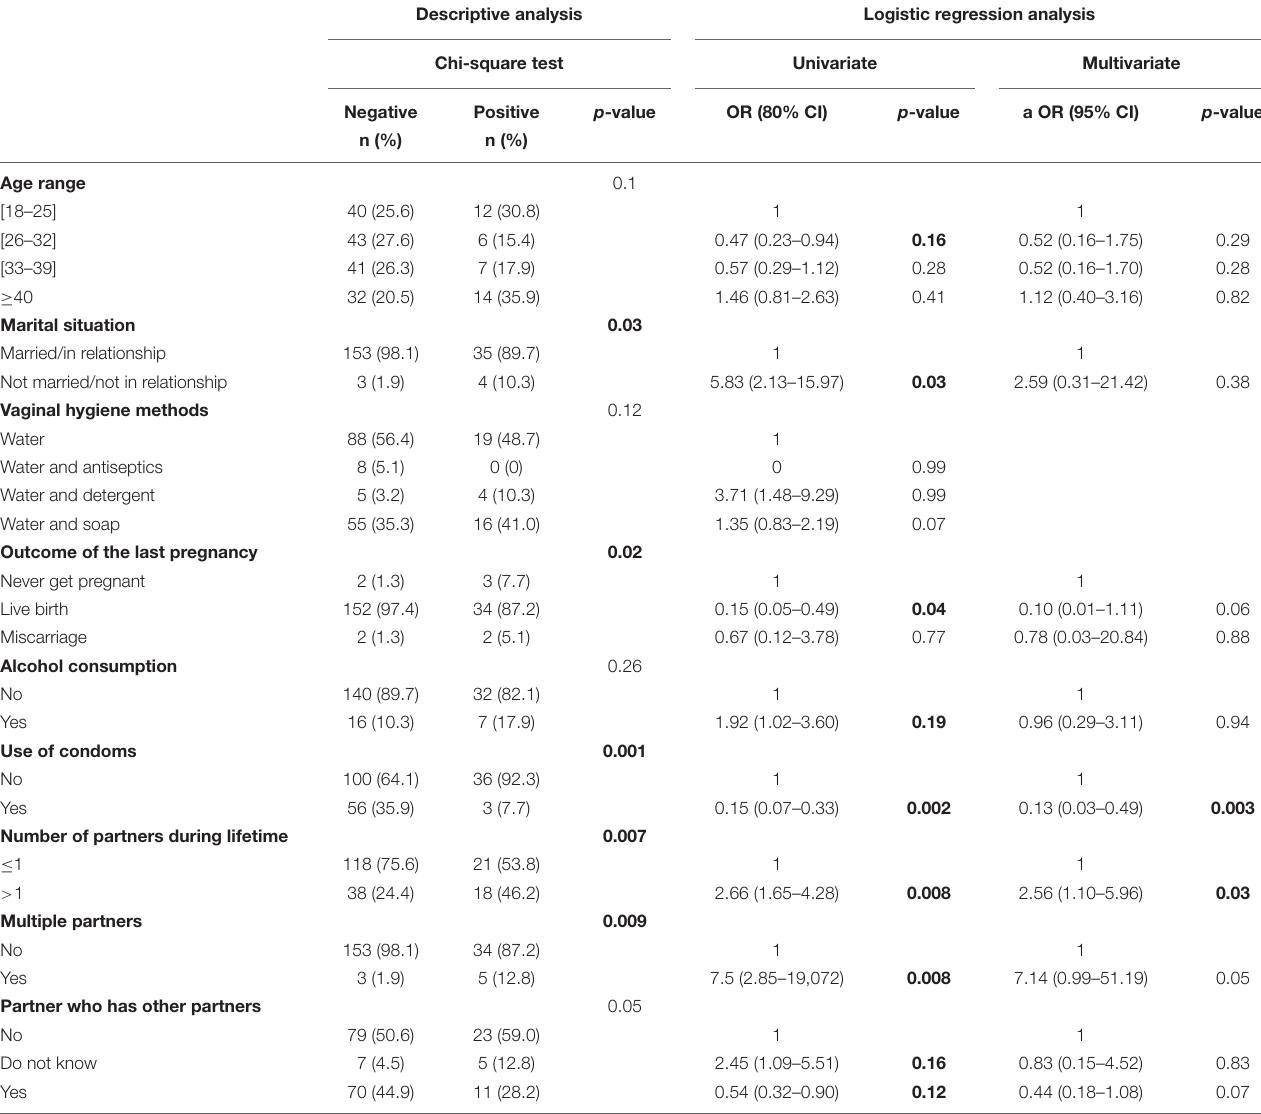
TABLE 3 | Descriptive and logistic regression analysis of factors associated with